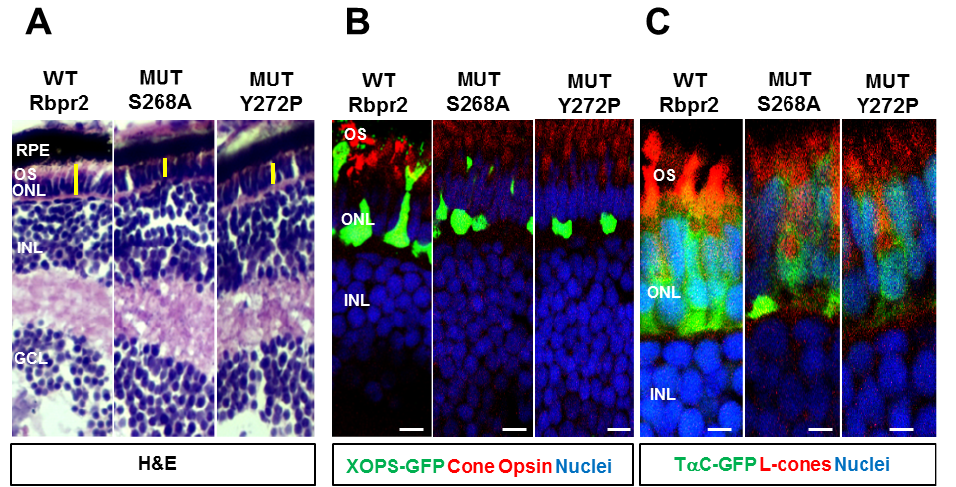
Figure 11. Histological analysis and immunostaining of rbpr2 fs-muz99 mutant larvae eyes after WT or mutant Rbpr2 mRNA injection. ( A ) Histological analysis and H&E staining, ( B ) immunostaining for R/G cone opsins, and ( C ) immunostaining for L-cones (1D4 antibody) of Tg: rbpr2 fs-muz99 mutant larvae eyes at 5.5 dpf, after WT- rbpr2 mRNA or mutant- rbpr2 mRNA injection. Scale bar = 50 µM ( B ); Scale bar = 25 µM ( C ). For each genotype, approximately 25–30 zebrafish larvae retinas were images/analyzed.